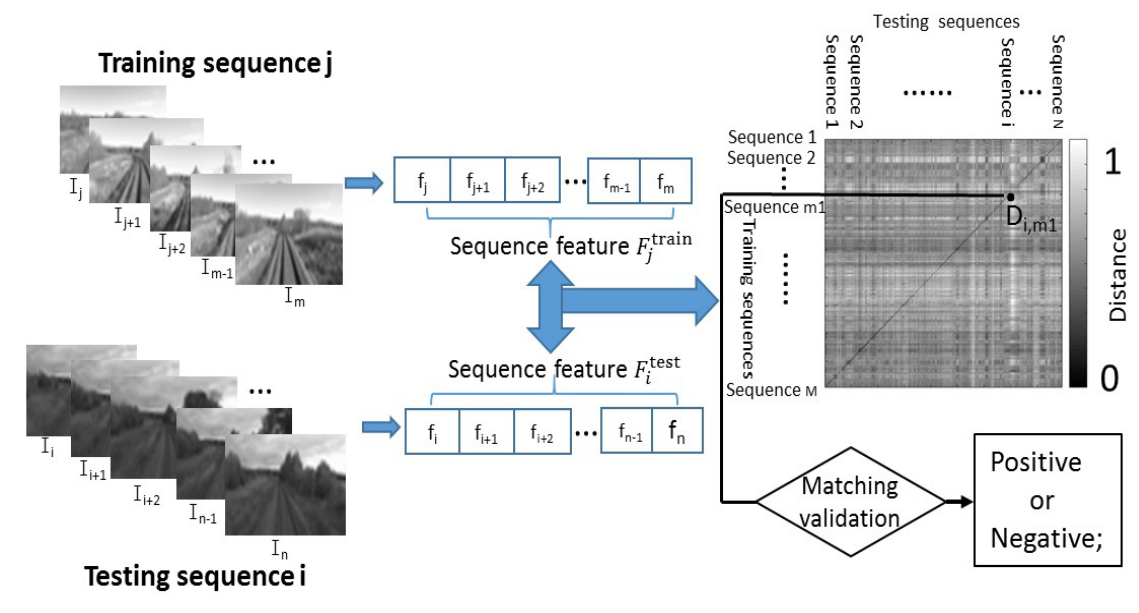
Figure 1. General diagram of visual localization system using sequence